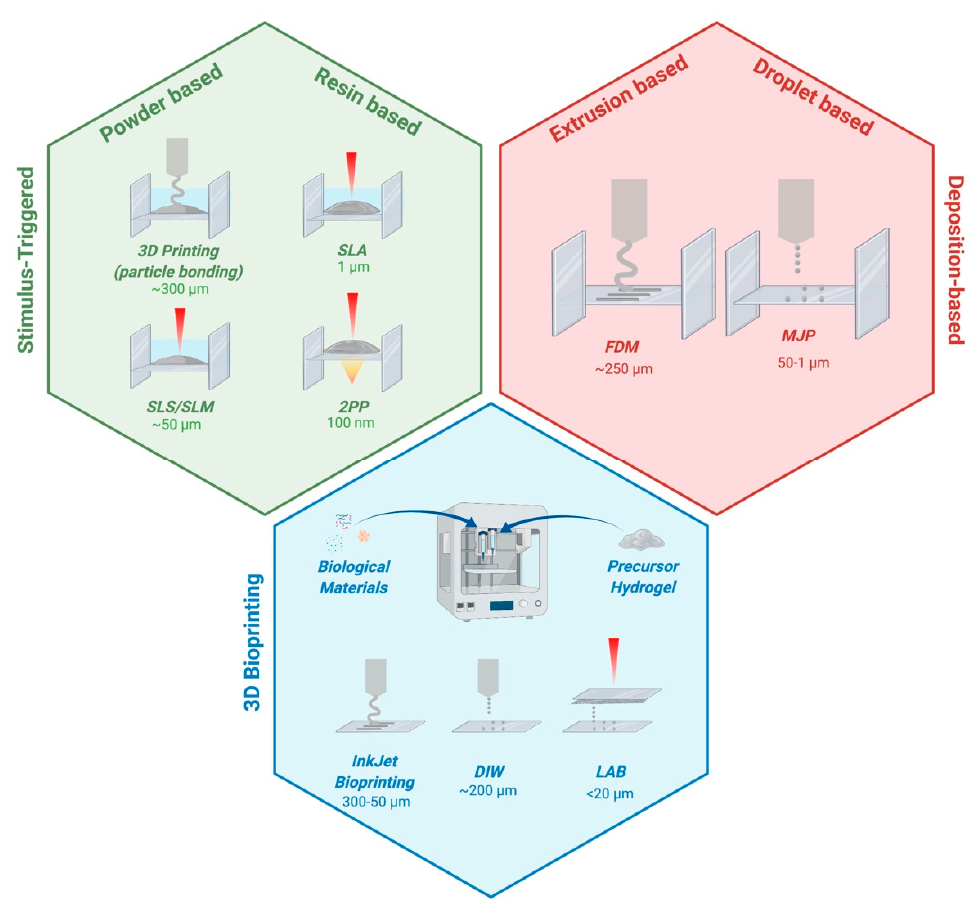
Figure 2. Summary of the three main categories of additive manufacturing techniques for scaffold fabrication. The top left hexagon reports the different stimulus-triggered approaches, subdividing